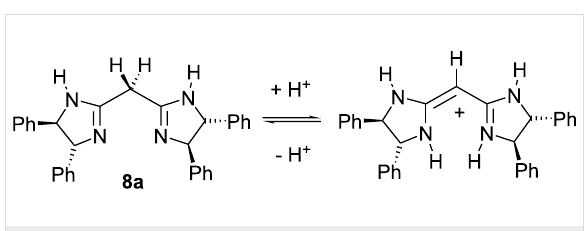
Scheme 2: Protonation states and tautomerism of C 2 -symmetric bisamidine 8a